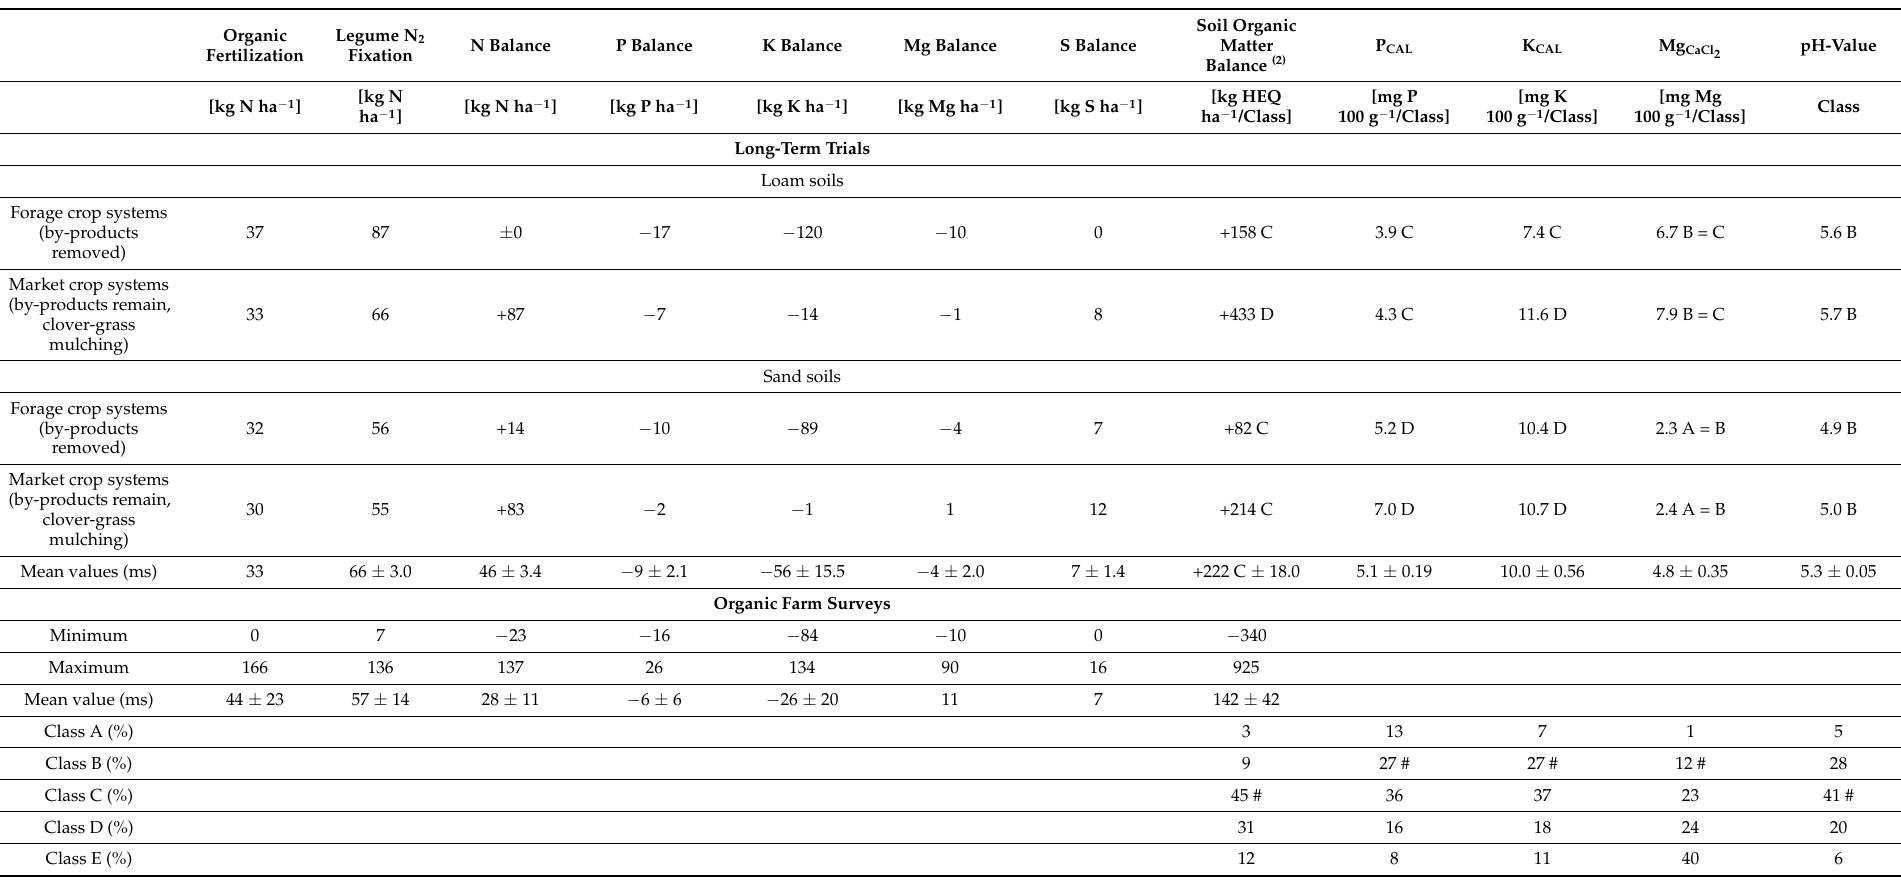
Table 8. Mean values, range of variation, and supply classes (1) of important characteristics of nutrient management and soil fertility of organic farming systems